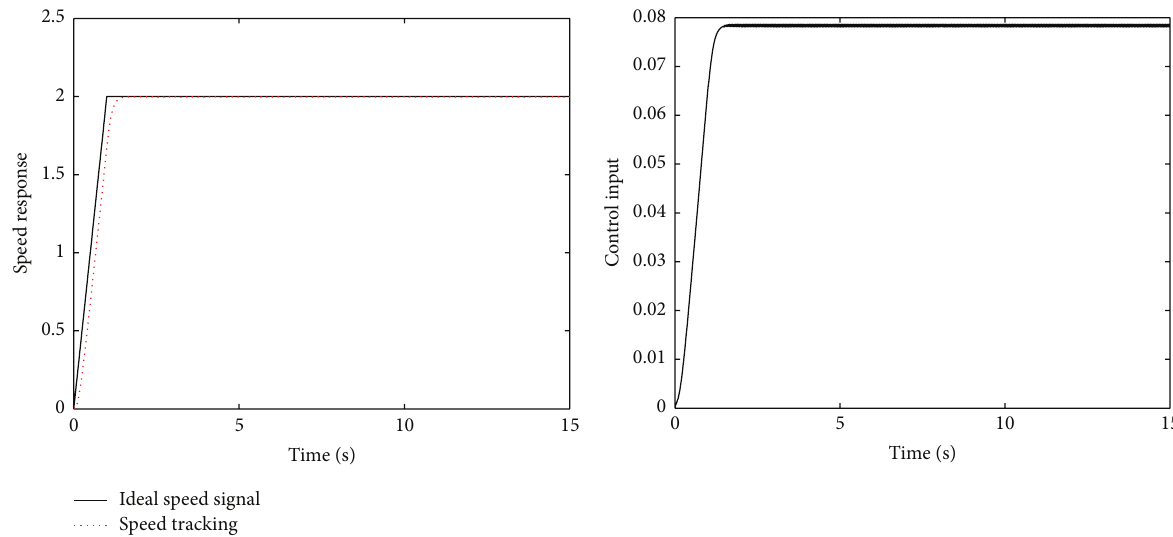
Figure 13: Simulation curve based on sliding mode control at constant speed.